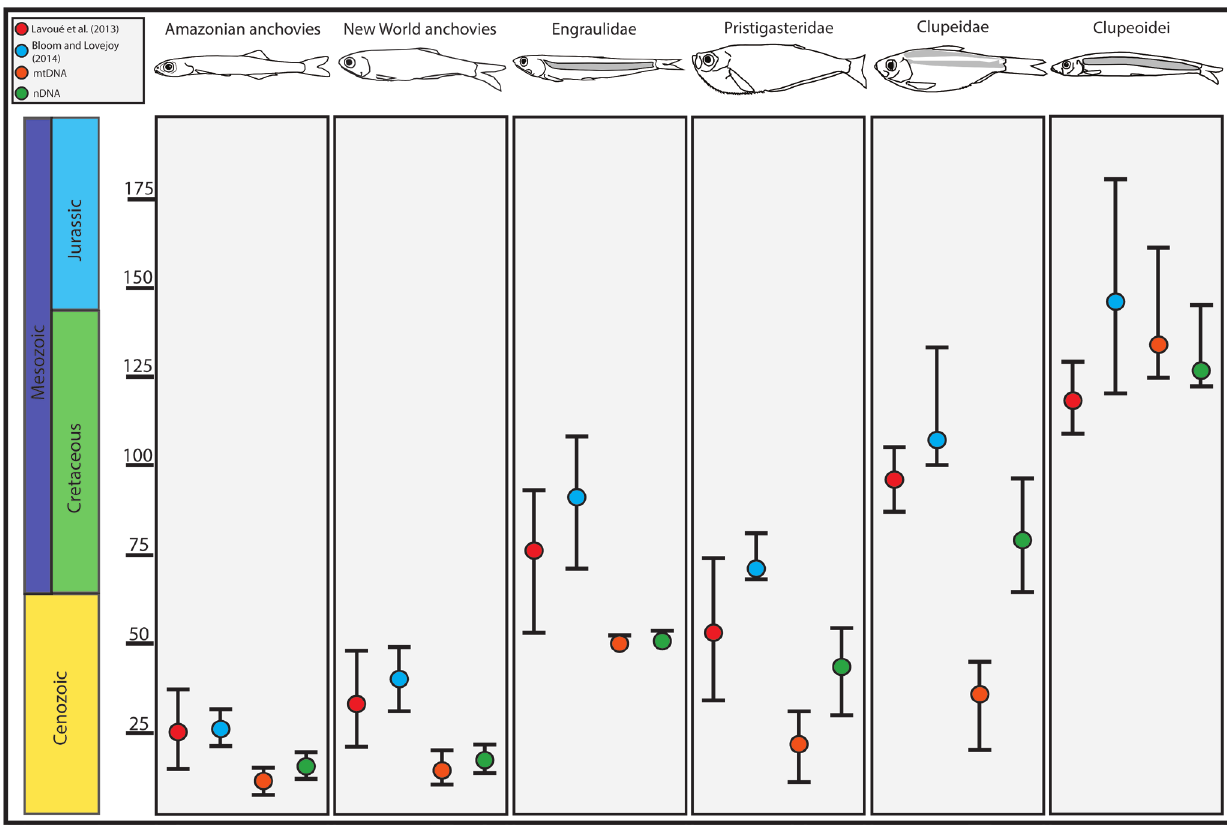
Fig. 4. Divergence time estimates for major clupeiform lineages estimated using nDNA and mtDNA separately by this study, mitochondrial genomes by Lavoué et al . (2013) and a combined mtDNA + nDNA dataset by Bloom, Lovejoy (2014). Time, in millions of years, is shown along the y-axis. Circles represent mean age estimates and whiskers delineate the 95% highest posterior density interval of divergence time